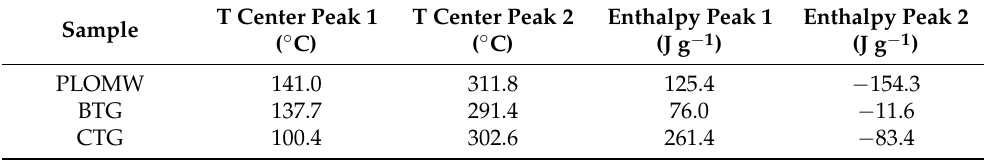
Table 4. Enthalpy and temperature values of the polymers and commercial tare rubber peaks.